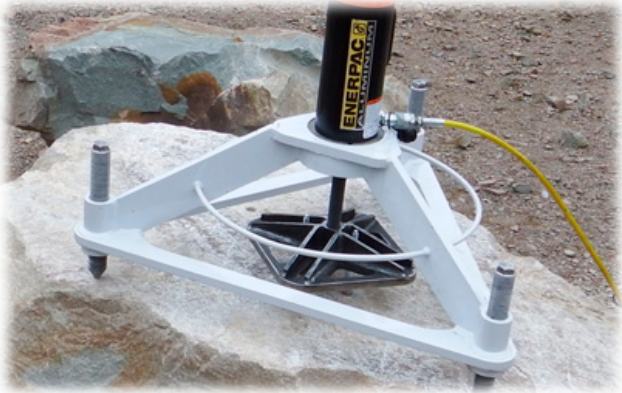
Figure 10. The jig frame for the hydraulic cylinder with the fastening plate and the system of two anchors.